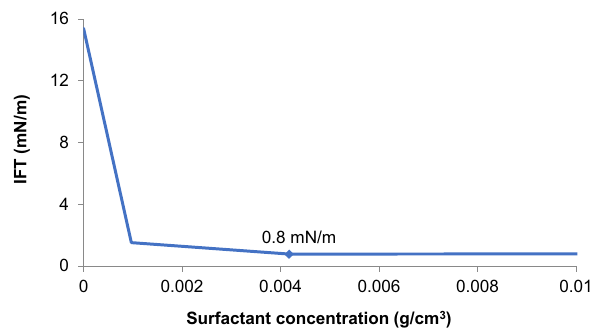
Fig. 5 Effect of surfactant concentration in solution on water/oil IFT